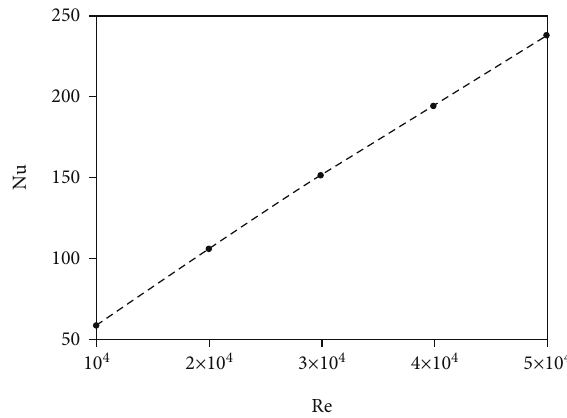
Figure 6: Average Nusselt number variations for di ff erent Reynolds ’ numbers.